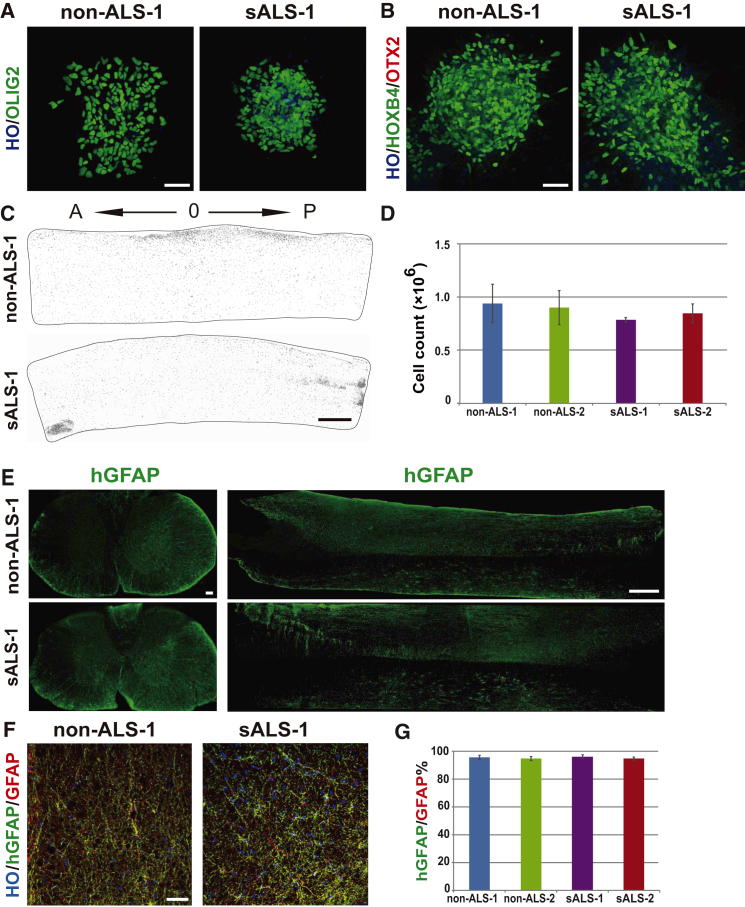
Characterization of Transplanted Human Cells in the Adult Mouse Spinal Cord(A) Immunofluorescent image of OLIG2 expression in differentiated neural progenitors at day 35. Scale bar, 50 μm. From three independent experiments.(B) Immunofluorescent image of HOXB4/OTX2 expression in differentiated neural progenitors at day 35. Scale bar, 50 μm. From three independent experiments.(C) Sagittal sections show the presence of sALS and non-ALS human cells (hNu+) in the adult spinal cord of SCID mice along the rostral (A) and caudal (P) direction, with “0” indicating the injection site. Scale bar, 500 μm.(D) Stereological quantification of human cells (hNu+) in the spinal cord of 10 mm in length covering the transplant site. Data are represented as mean ± SEM from three independent experiments, with n = 6 mice for each group.(E) The coronal and longitudinal distribution of hGFAP-expressing astrocytes, Scale bar, 50 μm (left panel), Scale bar, 1000 μm (right panel).(F) Representative transplanted spinal cord sections stained for human-specific GFAP (hGFAP, green) and pan-GFAP (red), Scale bar, 50 μm.(G) Quantification of hGFAP+ and GFAP+ cells in the transplanted spinal cord. Data are represented as mean ± SEM with n = 6 mice for each group.See also Figures S1 and S2.